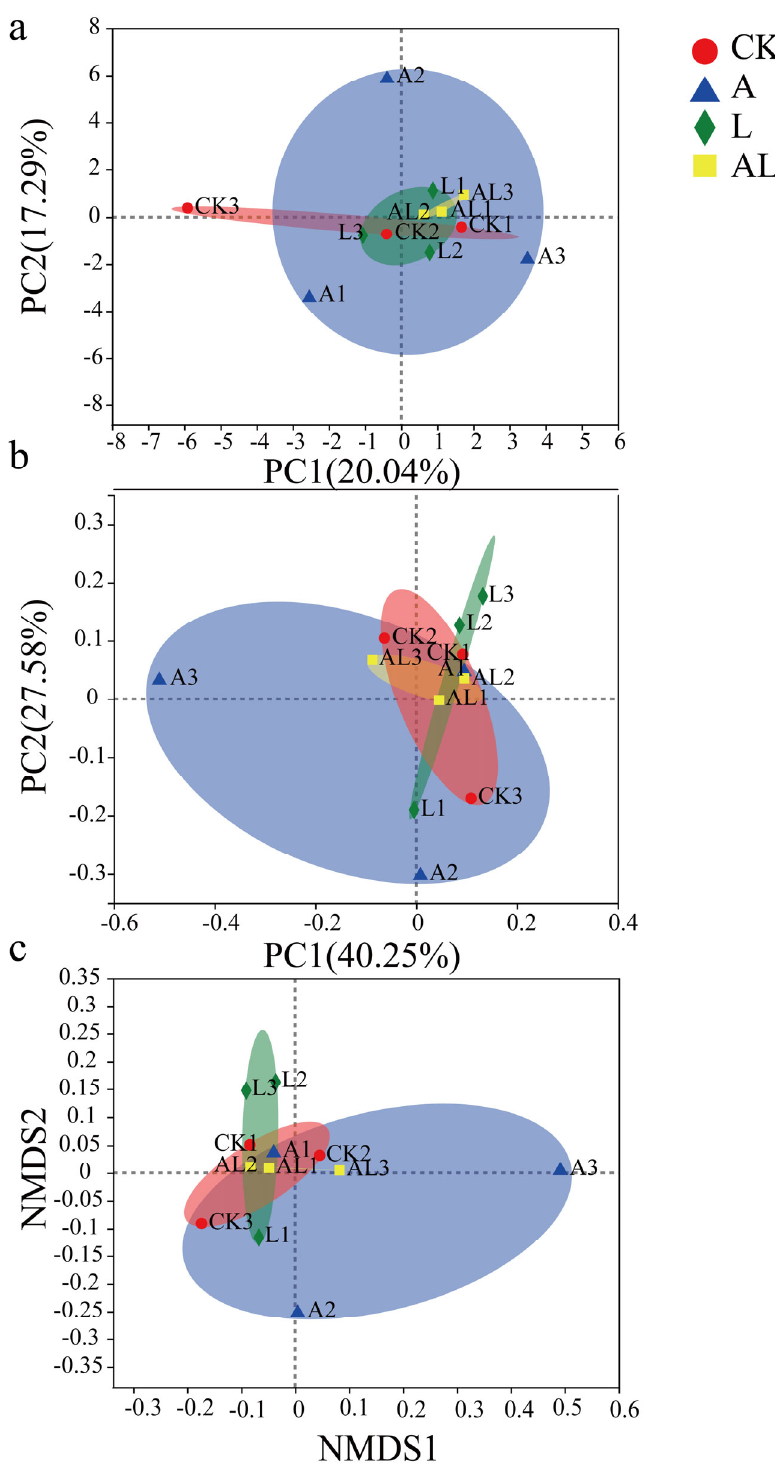
Figure 7. Biological diversity of intestinal bacteria in honeybees at the β level, assessed using: ( a ) principal component analysis; ( b ) principal coordinate analysis; and ( c ) nonmetric multidimensional scaling. Different colors represent different groups. The circle represents confidence ellipse.